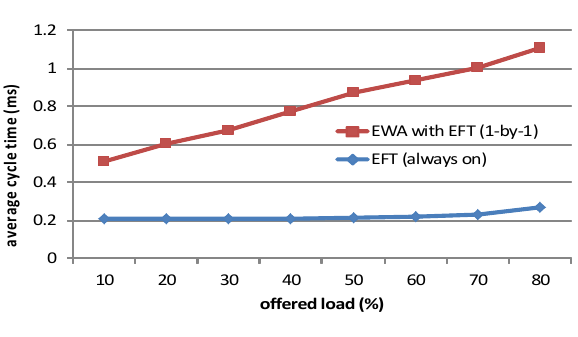
Figure 6. Average cycle